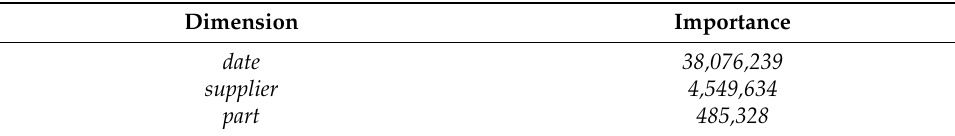
Table 4. Dimension importance for the